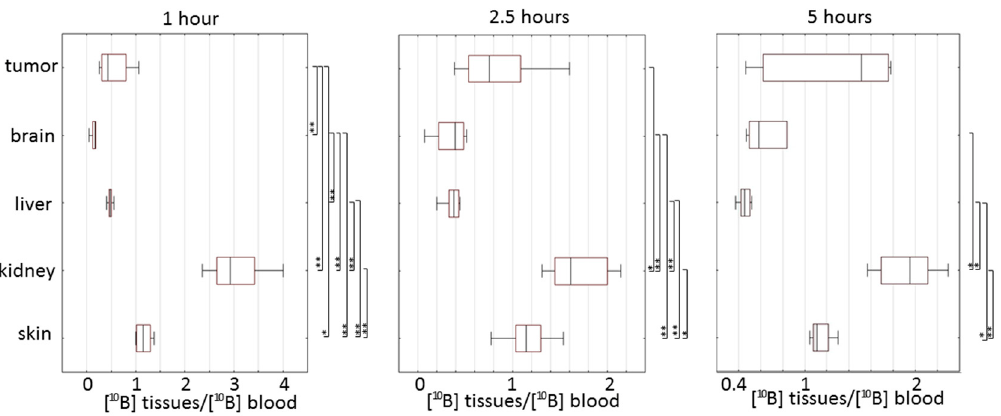
Figure 5. Box plots of [ 10 B] ratios between tissues and blood in different tissues at 1, 2.5 and 5 h after injection of BPA. Box borders indicate 25th and 75th percentiles; line boxes indicate the median. Significance of differences for 10 B uptake in tissue was defined by Mann–Whitney pairwise comparison followed by a Bonferroni post-test. * Statistical difference at p < 0.05. ** Statistical difference at p < 0.001.